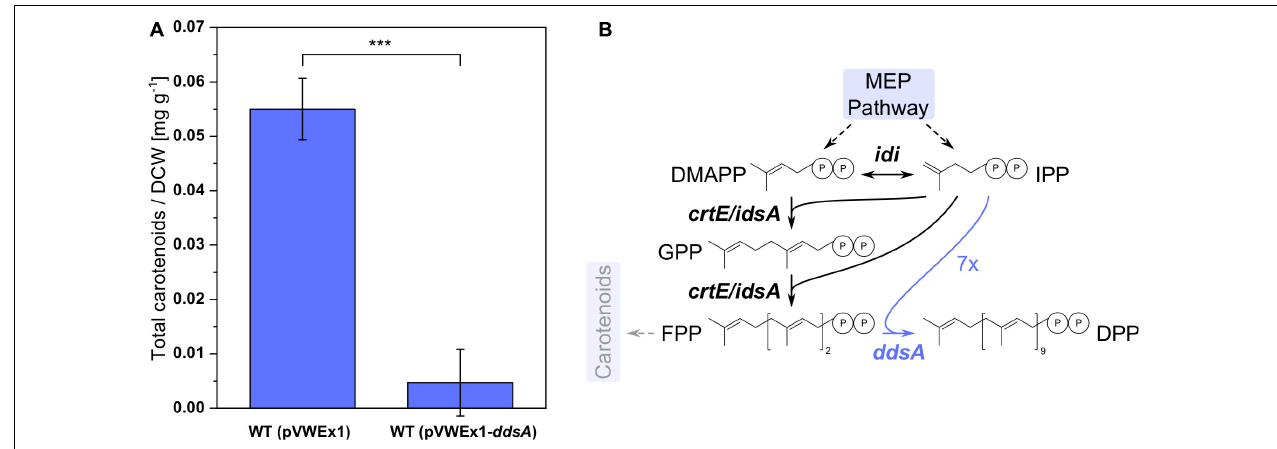
FIGURE 2 | Carotenoid synthesis in C. glutamicum WT with and without expression of ddsA . (A) Total carotenoid amount per dry cell weight from WT (pVWEx1) and WT (pVWEx1- ddsA ). (B) Pathway of isoprenoids with diverging reactions from FPP to DPP and carotenoids. The heterologous expression of ddsA is highlighted in blue. MEP, 2-C-methylerythritol 4-phosphate; IPP, isopentenyl diphosphate; DMAPP, dimethylallyl diphosphate; GPP, geranyl diphosphate; FPP, farnesyl diphosphate; DPP, decaprenyl diphosphate; idi , isopentenyl diphosphate isomerase; crtE , geranylgeranyl diphosphate synthase; idsA , geranylgeranyl diphosphate